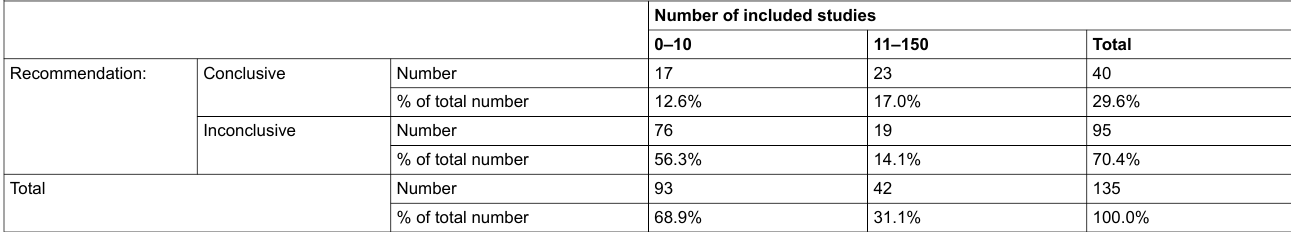
Table 3: Number of studies included in Cochrane reviews and conclusiveness of the